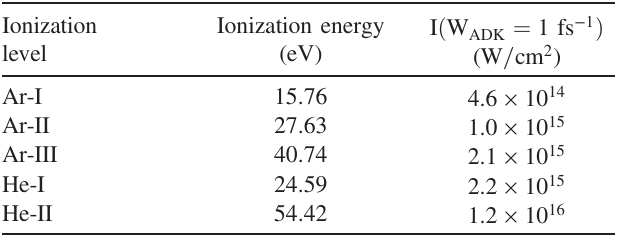
TABLE I. Relevant ionization energies [64] and the corre- sponding laser intensities for a tunnel ionization rate [51] of 1 fs − 1 at a laser wavelength of 800 nm.